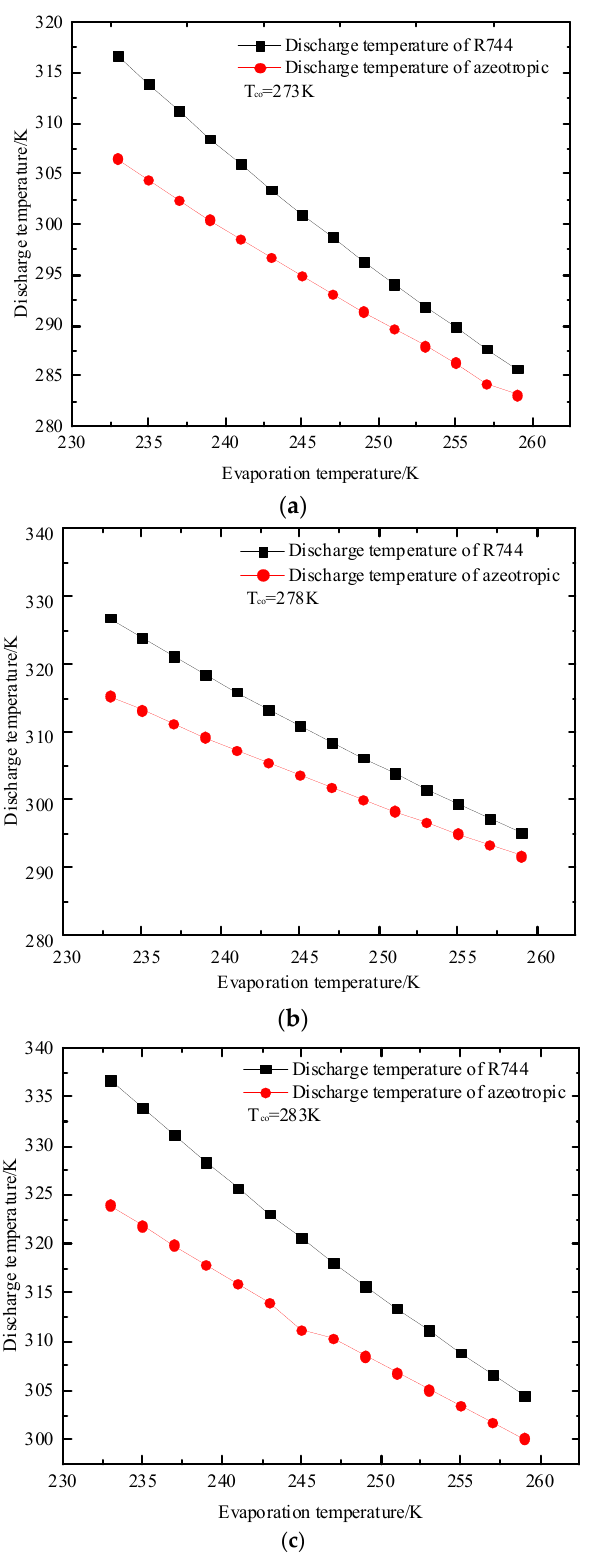
Figure 22. Comparison of COP values of azeotropic refrigerant and R744 varies with evaporation temperature at different outlet temperatures of condenser: ( a ) T co = 273K; ( b ) T co = 278K; ( c ) T co = 283K.